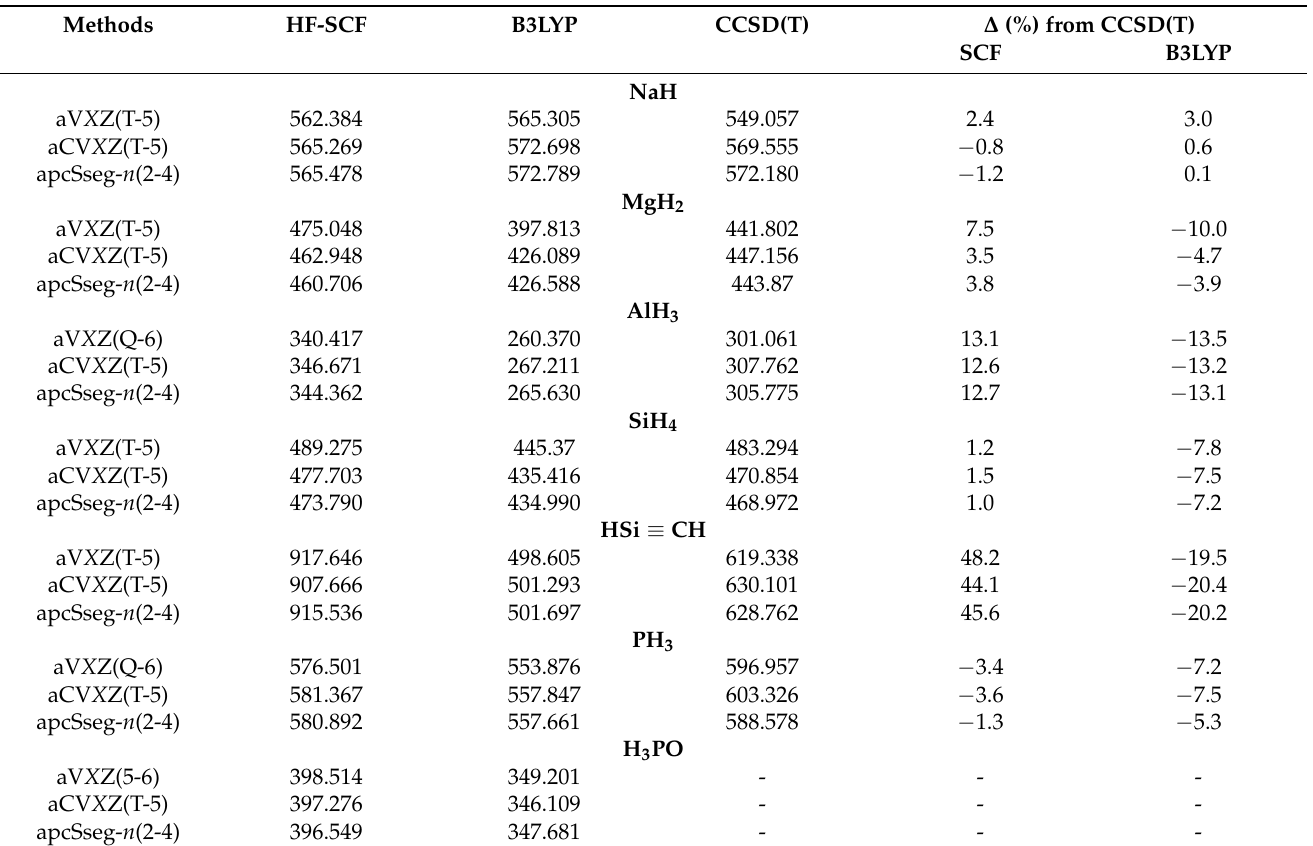
Table 3. Calculated CBS nuclear shielding values (in ppm) for studied species a,b